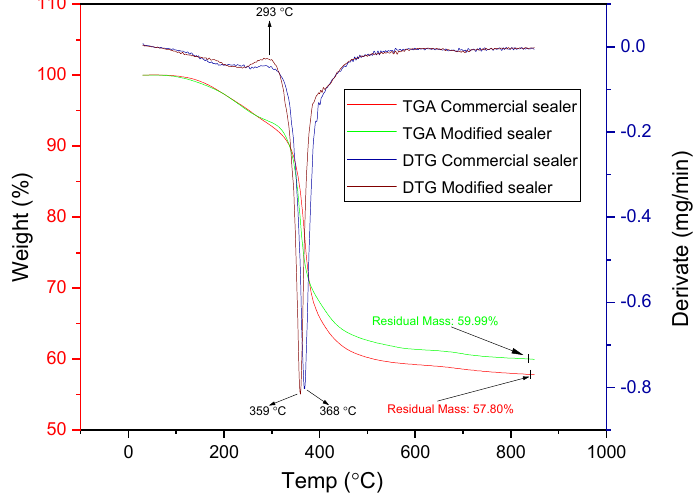
Figure 7. TGA and DTG thermograms of the modified and commercial sealers.